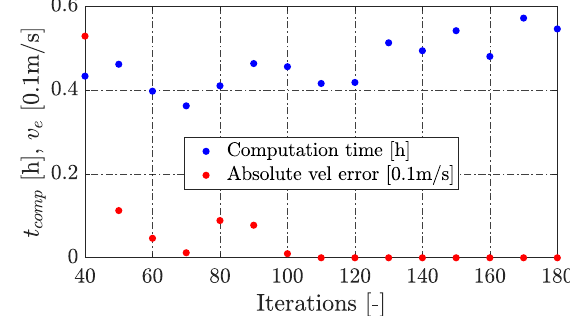
Figure 9: Time period and velocity error ( v e ) for switching a valve, evaluated by CFD anal-